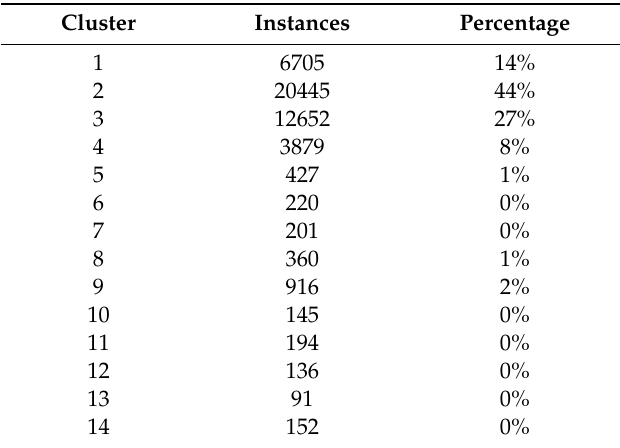
Table 4. The results of canopy